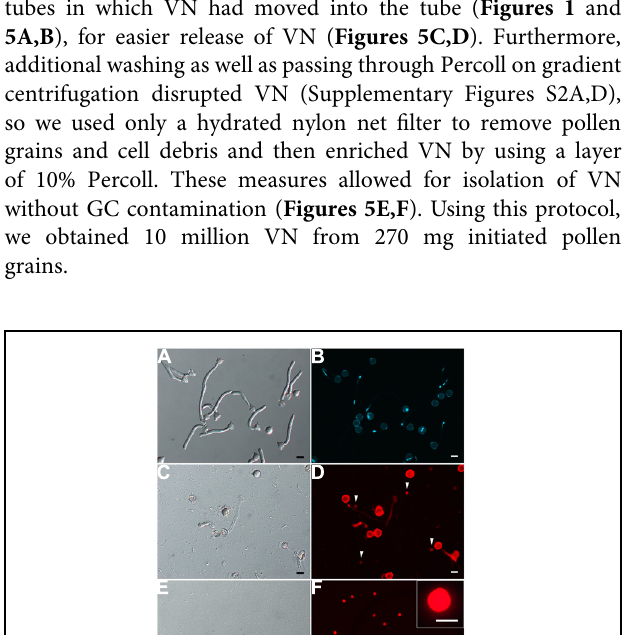
FIGURE 3 | Isolation of GCs from just-germinated pollen grains. (A) Pollen grains were geminated in vitro for 20 min, and most produced pollen tubes. (B) 10-min osmotic shock of germinated pollen grains in osmotic shock solution led to a burst of most of pollen tubes. The inset image in (C) and (D) shows change of just-released GC from spindle-shaped (C) to oval-shaped (D) . (E,F) DIC microscopy (E) and viability with fluorescein diacetate (FDA) staining (F) of purified GCs . Close-up of GCs in inset images (E,F) . Scale bar: 20 μ m.